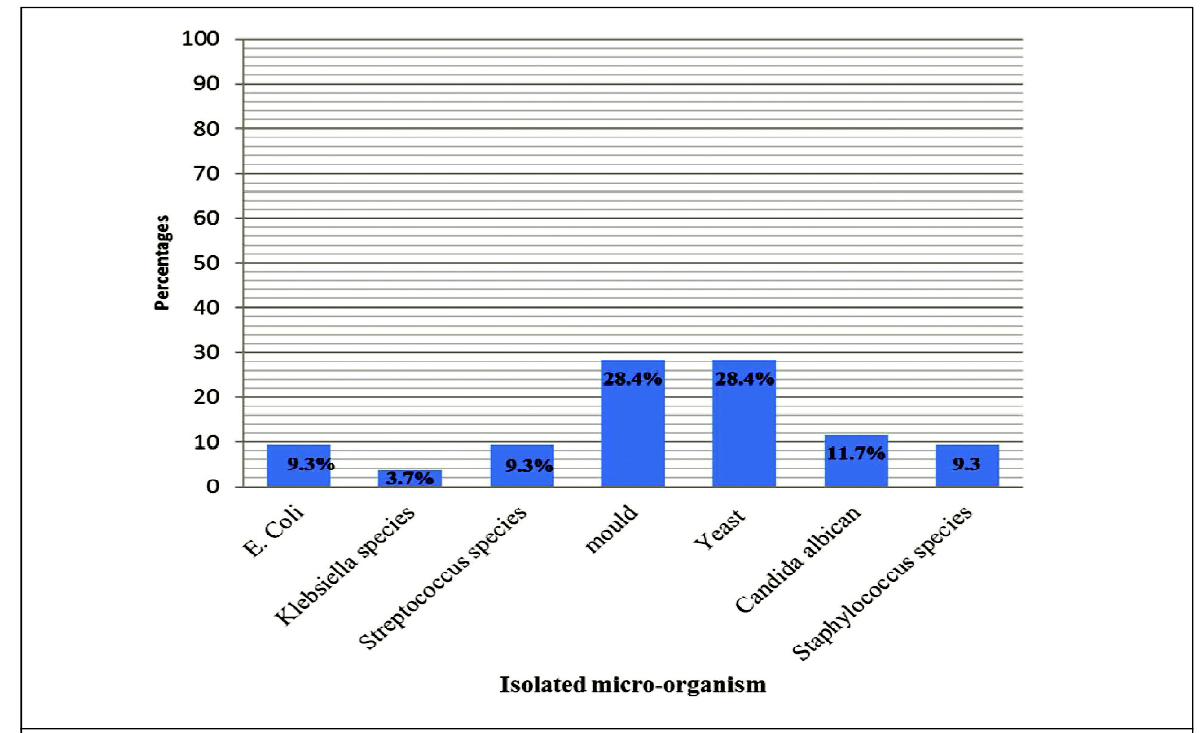
Figure 1: Identified microorganisms in women suspected to have chorioamnionitis